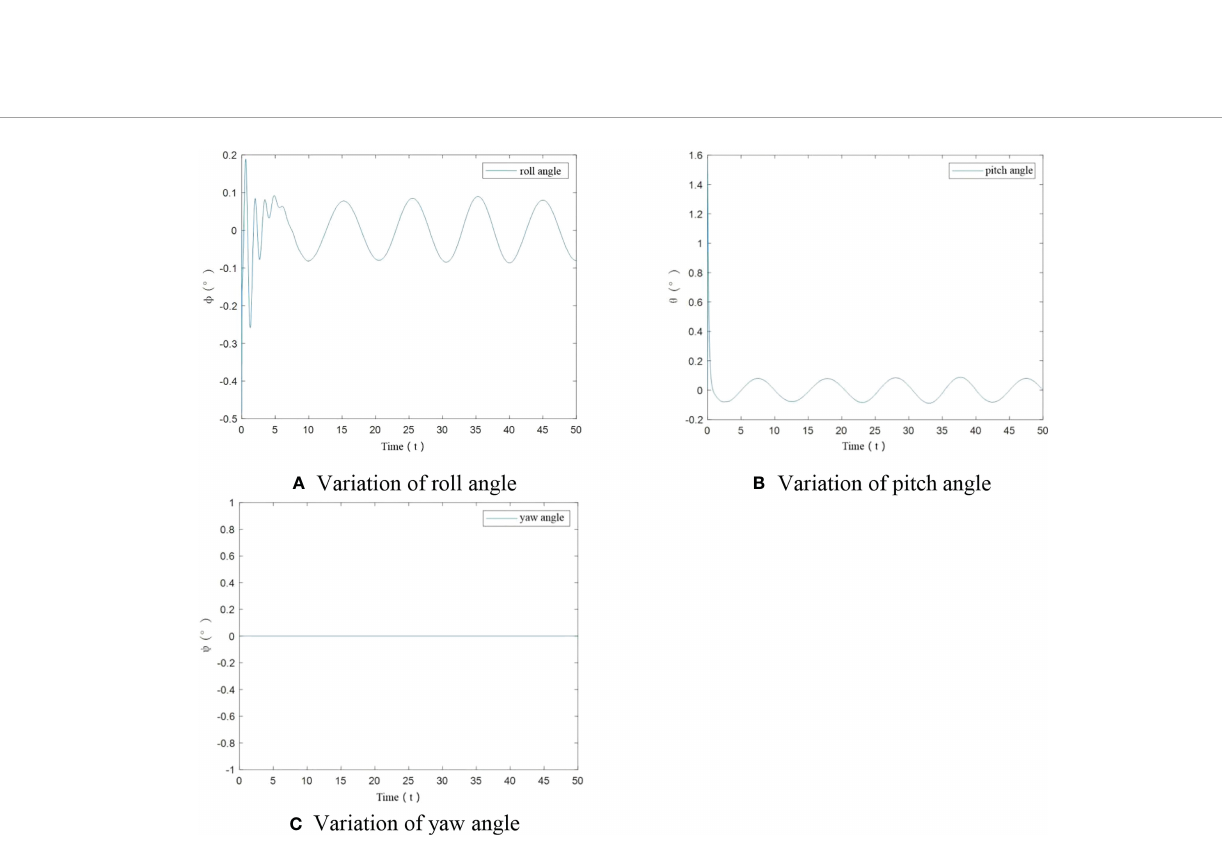
FIGURE 15 Angular variation for UAV under load variation. (A) Variation of roll angle, (B) Variation of pitch angle, (C) Variation of yaw angle.